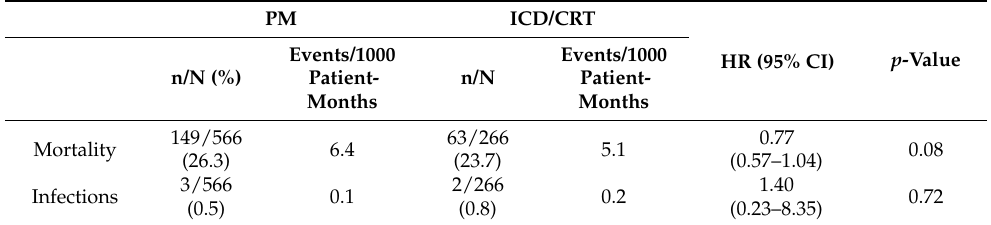
Table 2. Study outcomes.